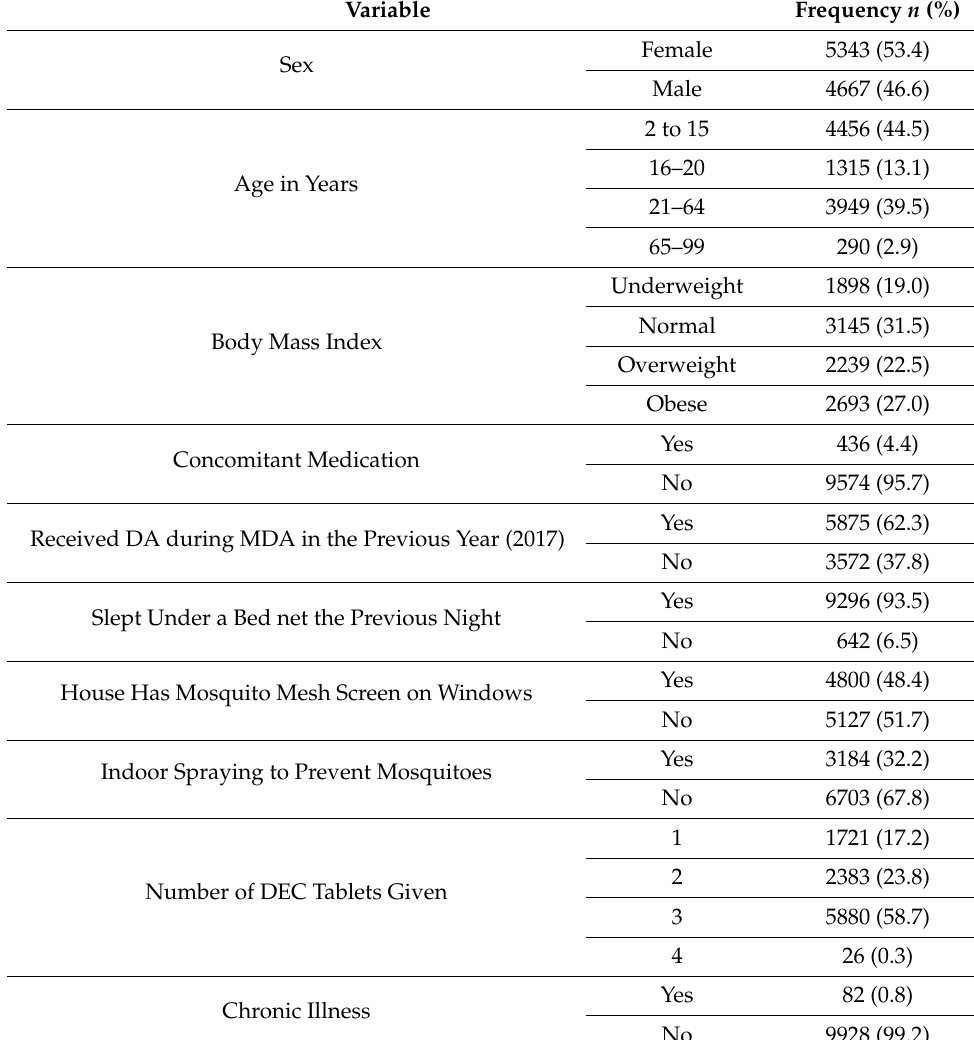
Table 1. Socio-demographic and baseline characteristics of study